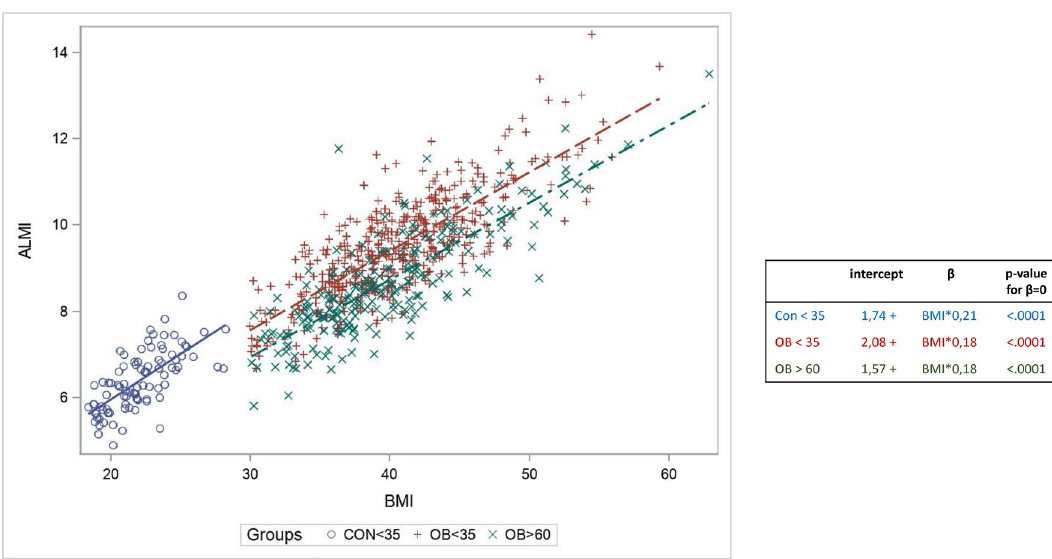
Figure 4. Linear regression explaining the ALMI of young obsese patients according to the BMI. ALMi: appendicular lean mass (sum if the lean soft tissue mass for the arms and legs)/height 2 , BMI: body mass index. CON: young women with normal weight; OB ≤ 35: young women (18–35 years) with obesity; OB > 60: older women (> 60 years) with obesity. Patients with ALMI < 0.6428224 + 0.18281*patient’s BMI can therefore be considered to be